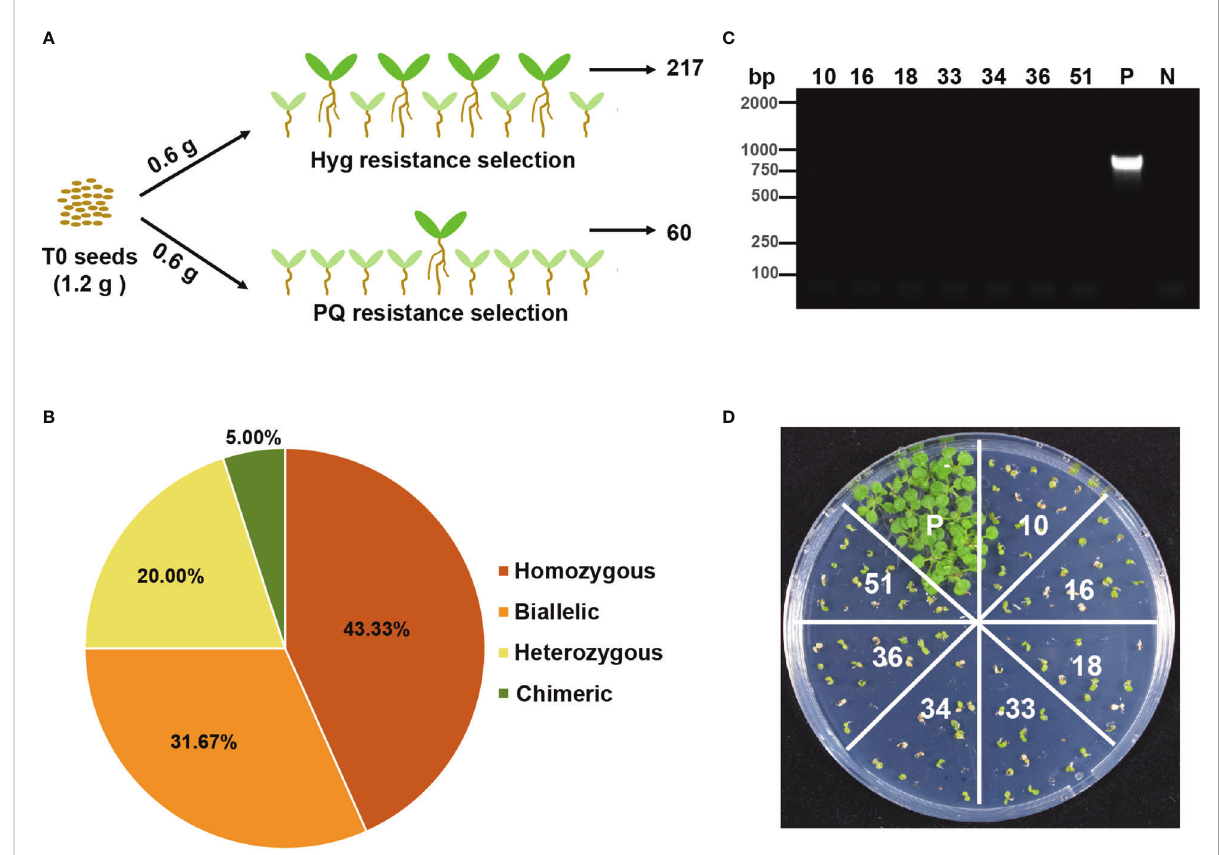
FIGURE 3 Transgene-free par1 mutants could be detected when T0 seeds were selected by paraquat. (A) Outline of selecting equal amount of T0 seeds transformed with sgRNA par1 by hygromycin and paraquat. (B) Percentages of different types of mutations at the PAR1 locus among all T1 plants selected on paraquat plates. (C) The PCR results of transgene-free T1 plants ampli fi ed with Cas 9-speci fi c primers. P: positive control (PCR with DNA extracted from a transgenic plant containing Cas9). N: no sample control (PCR with no DNA sample). (D) The progenies of transgene-free par1 mutants are sensitive to hygromycin. Seeds of these transgene-free T1 plants were sown on 1/2 MS plates supplemented with 25 mg/L hygromycin for two